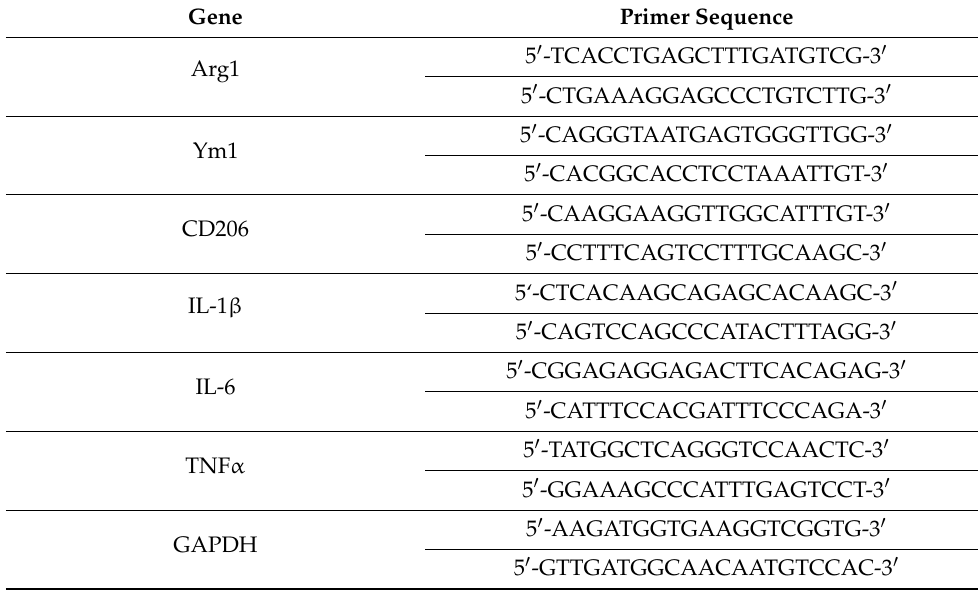
Table 1. Primer sequences for quantitative real-time PCR